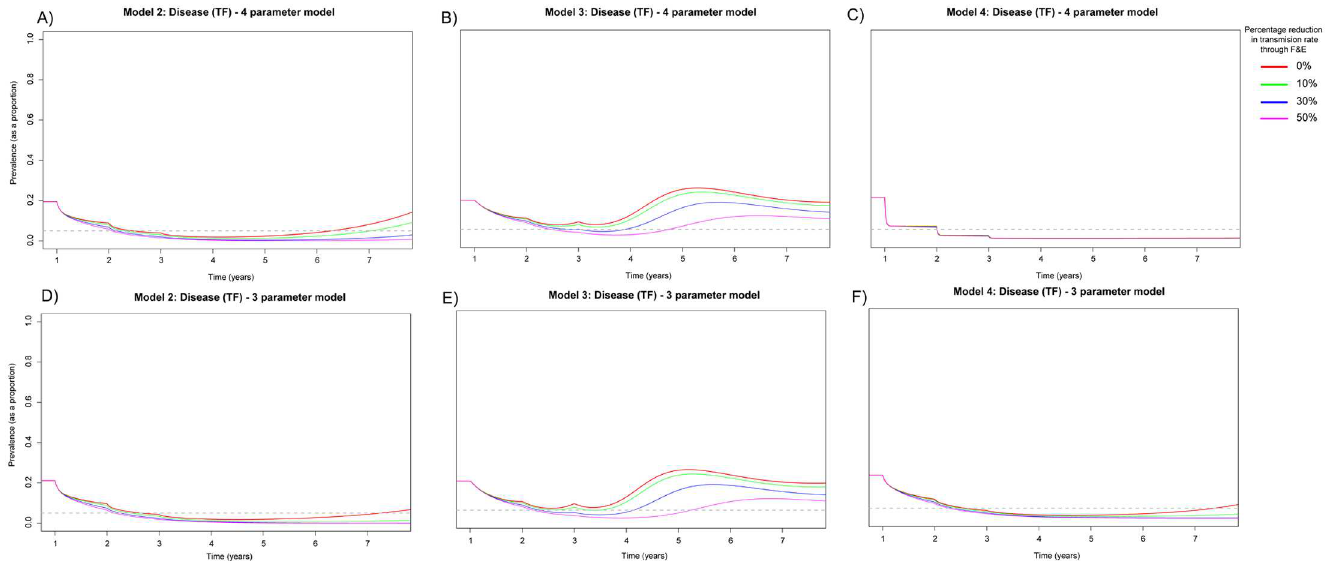
Fig 4. Prevalence of TF in 0–9 year olds when MDA has been applied for 3 annual rounds for 3 yearswithin a community with 20% TF prevalence. A) Model 2 assuming20% susceptibilityto re-infection in the D and assumingan individual’sinfectivity decayedexponentially with each successive infection. B) Model 3 assuming20% susceptibility to re-infectionin the PD and assumingan individual’s infectivity decayedexponentially with each successiveinfection. C) Model 4 assuming80% susceptibility to re-infectionin the D and assumingan individual’sinfectivity decayed exponentially with each successive infection. D) Model 2 assuming 20% susceptibilityto re-infectionin the D and assuminga linear declinein infectivity with each successive infection. E) Model 3 assuming20% susceptibility to re-infectionin the PD and assuminga linear declinein infectivity with each successive infection. F) Model 4 assuming80% susceptibility to re-infectionin the D and assuminga linear declinein infectivity with each successiveinfection. For the 4 and 3 parameter versions of Models 2–4 (A–F) we considered variablereductions in the transmission rate β that may be achievablethrough facial cleanliness and environmental improvements (F&E). We considerinstantaneous non-lineardeclinesin β across the 5 year interventionperiod. We considered maximum reductionsin β over the 3 year interventionperiodto be 0, 10, 30 or 50% from the initial value